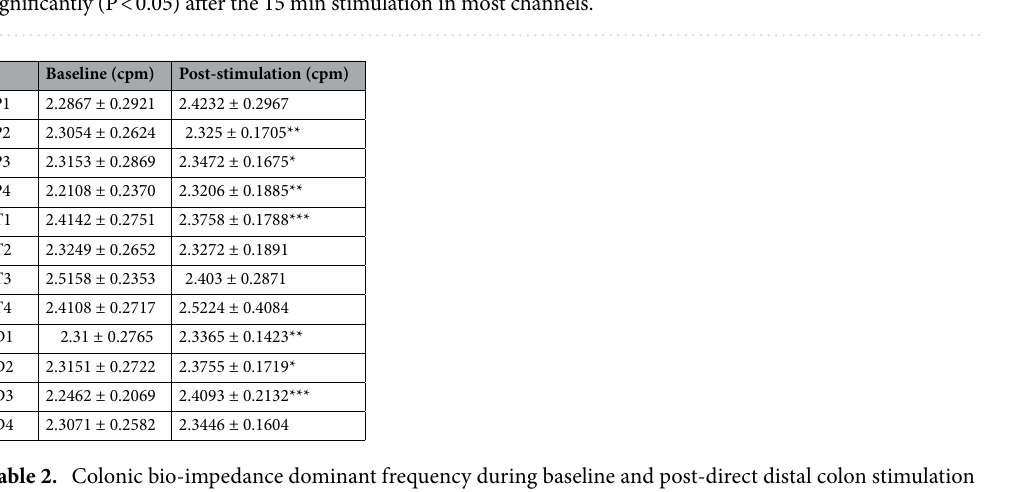
Figure 6. Example of different bio-impedance responses in frequency domain in proximal (P1), transverse (T1), and distal colon (D2). Peak frequencies are observed in the majority of the channels. The dominant frequency is in the range of 2–3 cpm. Dominant frequency (frequency with most power) shifts to the right significantly (P < 0.05) after the 15 min stimulation in most channels.